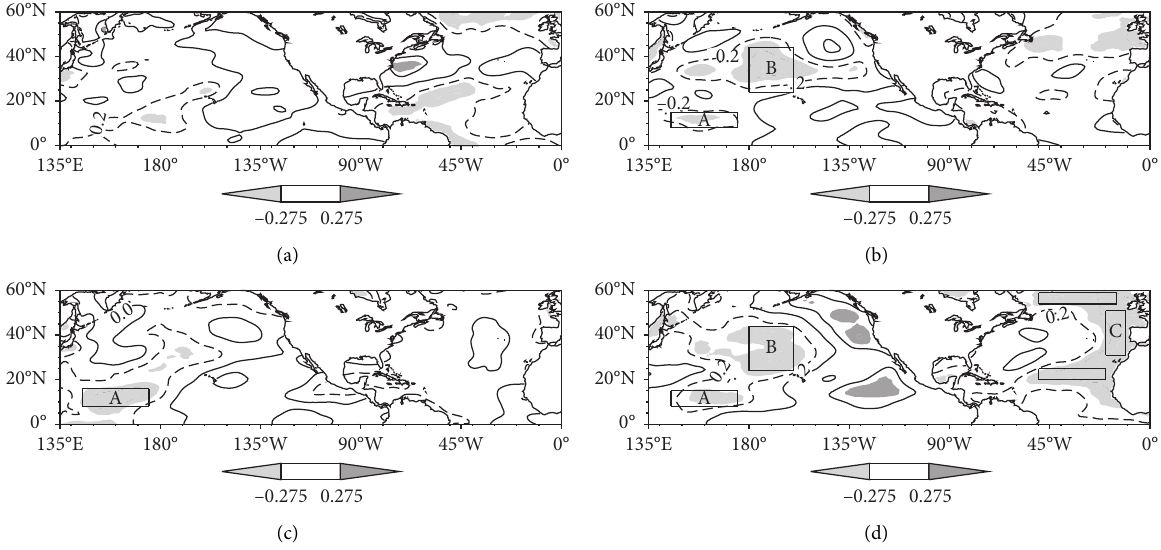
Figure 5: The lead-lag and contemporaneous correlation coefficients between the frequency of the winter SSECEs in North China and the SSTA in spring (a), summer (b), autumn (c), and winter (d). Shaded areas represent statistical significance at the 90% confidence level using Student’s t -test and the rectangles with A, B, and C are the SST key areas.